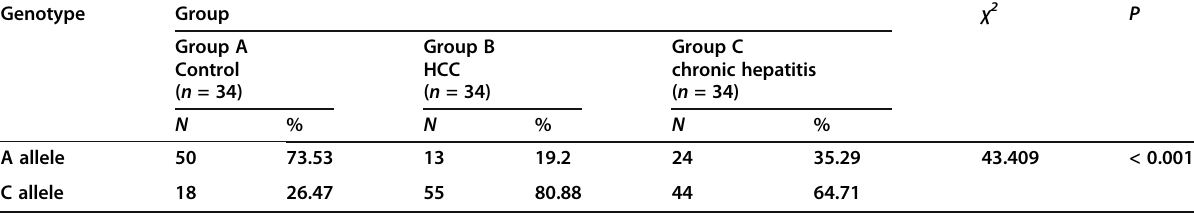
Table 3 Comparison between the three studied groups according to allele frequency Genotype